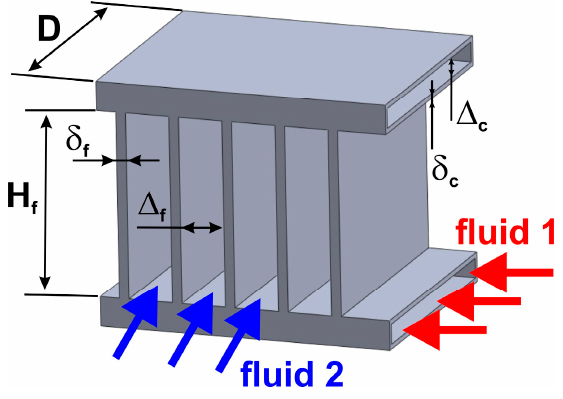
Figure 1. Geometry and dimensions of the core of plate fin heat exchanger.